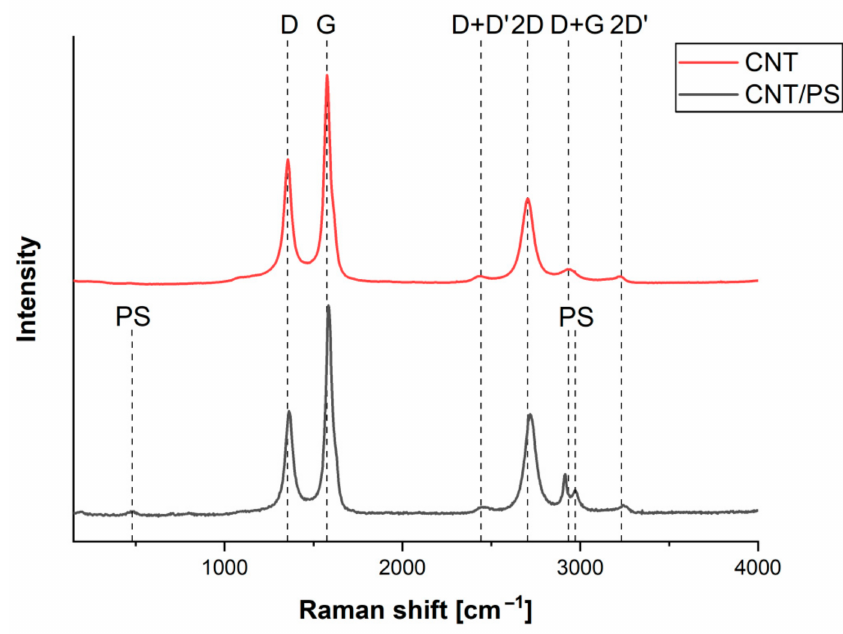
Figure 2. Normalized averaged spectra of pure CNT and co-deposited